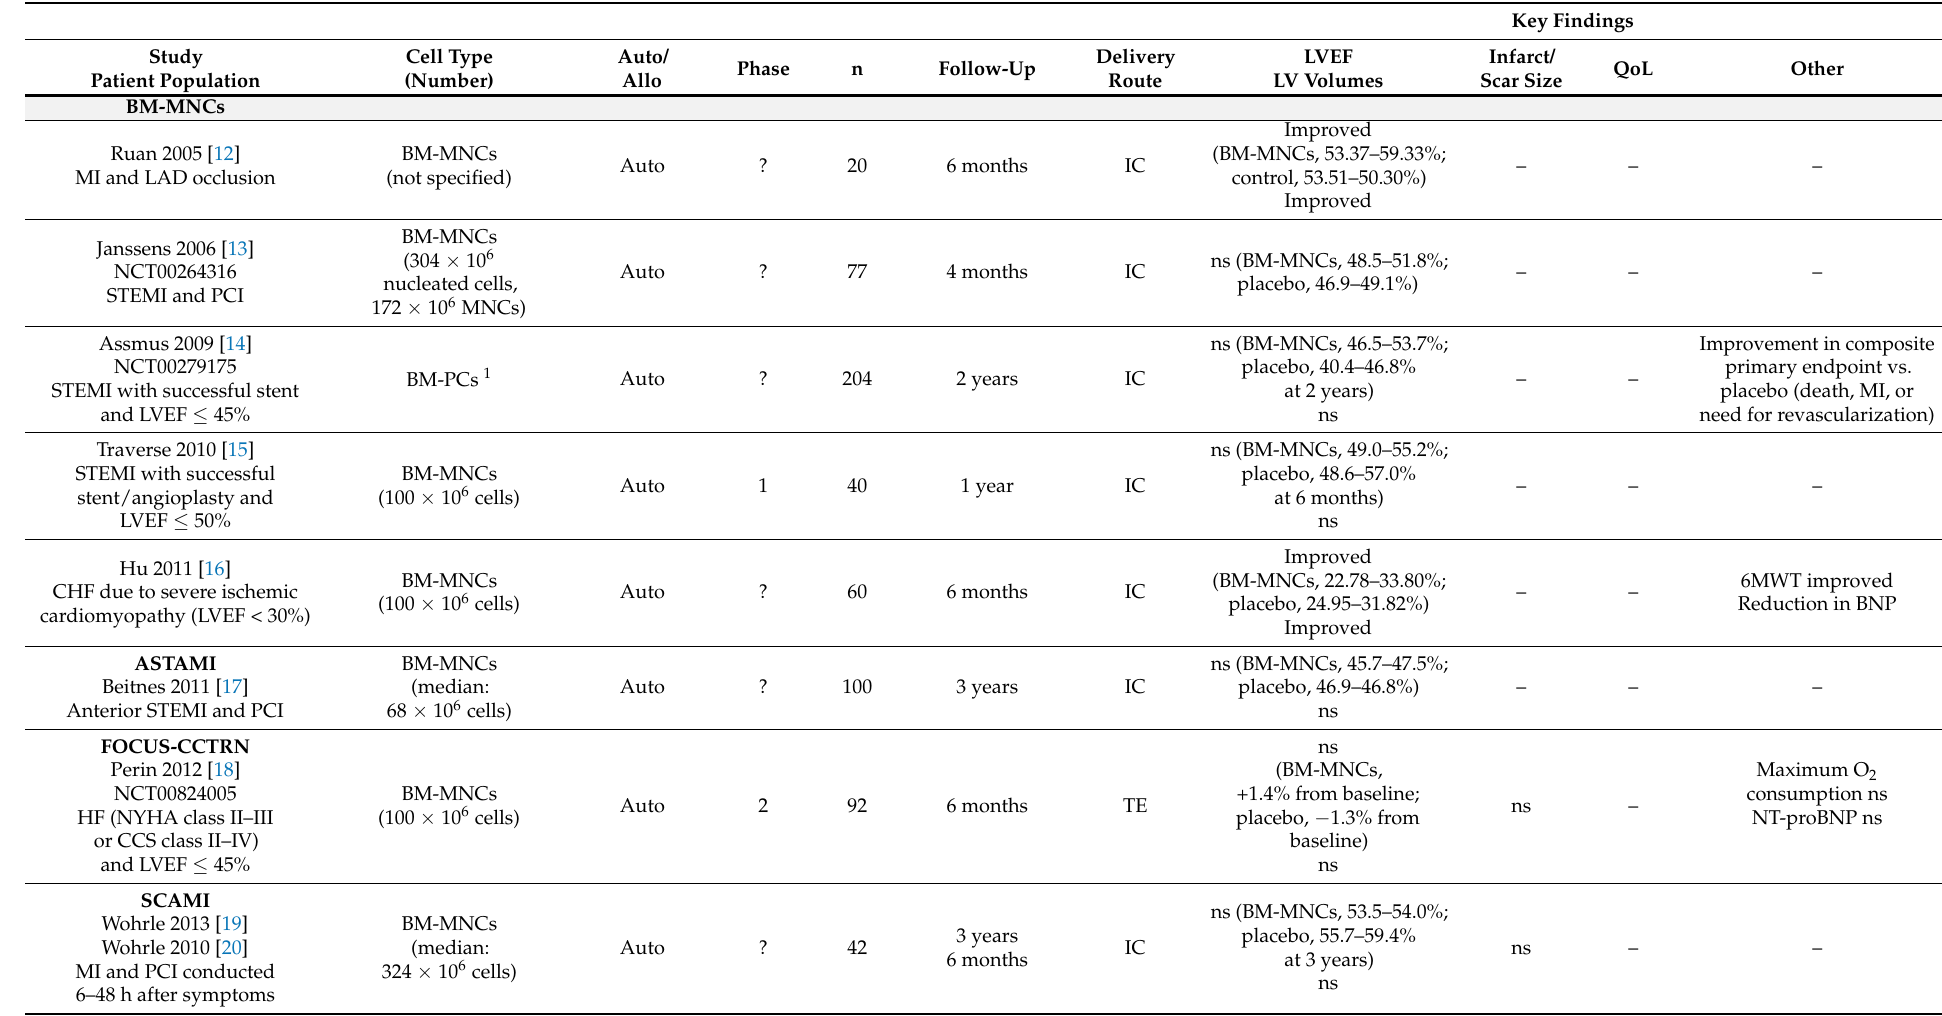
Table 1. Double-blind clinical trials of first-generation cell-based therapies for the treatment of